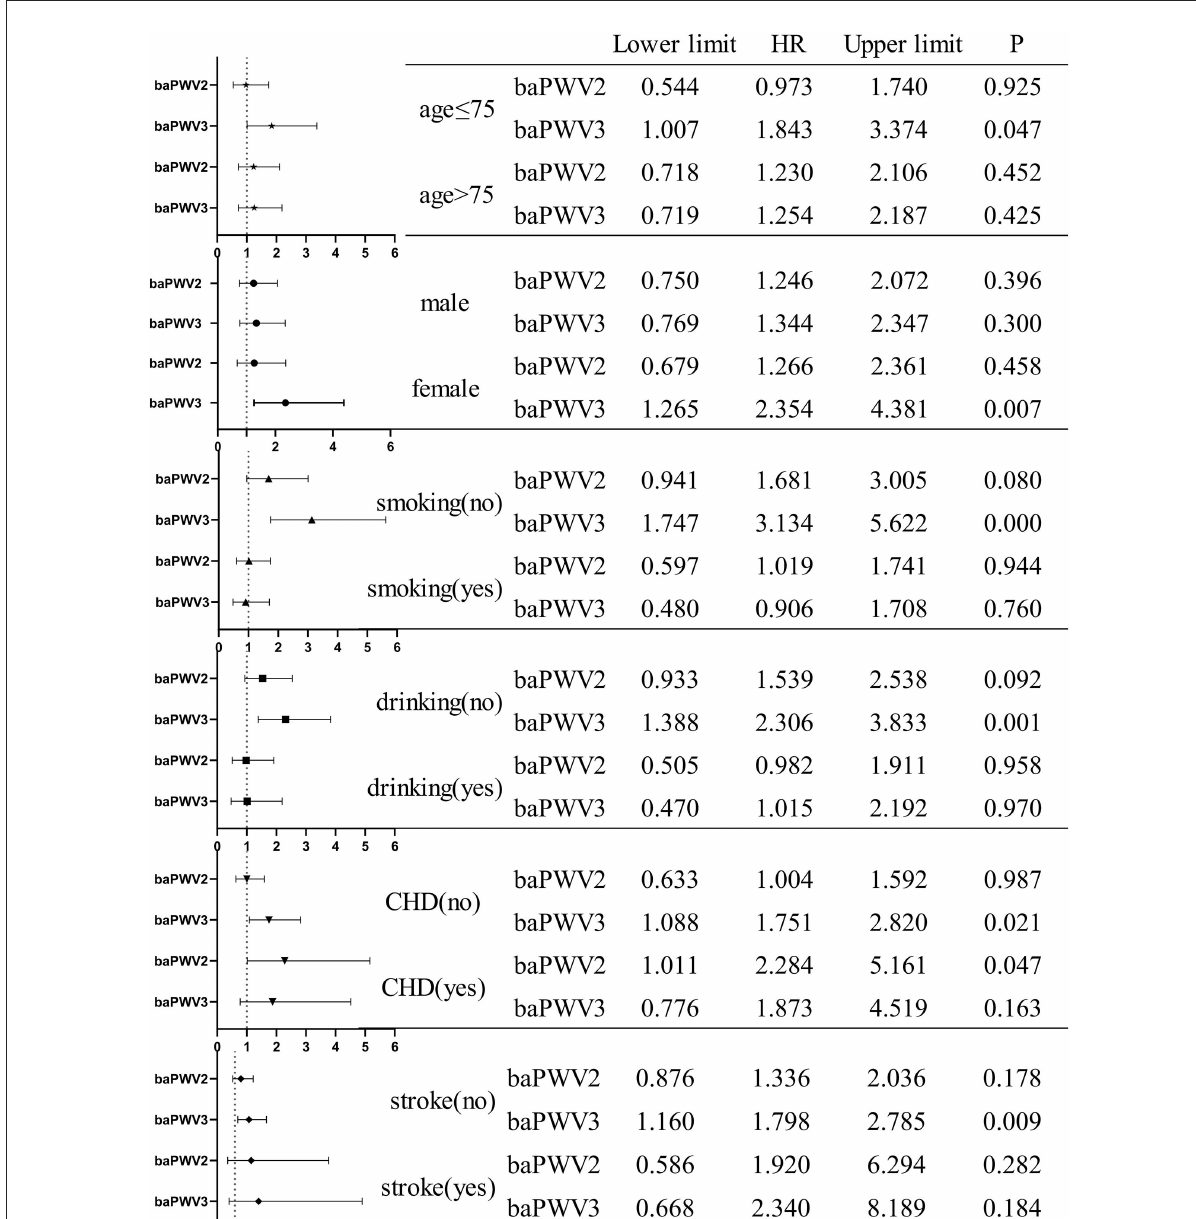
FIGURE7 Forest map with stratified analysis by age, sex, smoking history, drinking history, history of coronary heart disease, and history of stroke.